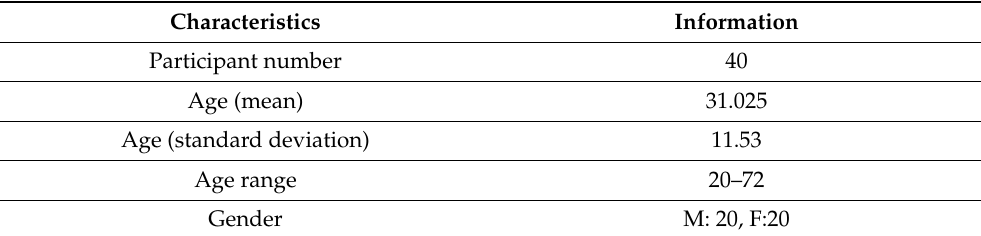
Table 1. Demographic information of the participants.